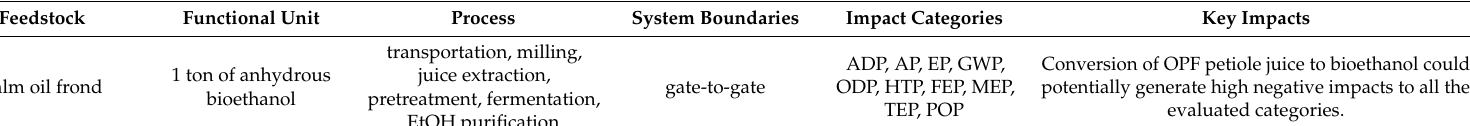
Table 2. Main characteristics considered in the reviewed